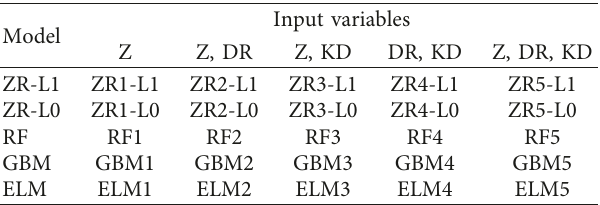
Table 3: Tested models for quantitative precipitation estimation from radar